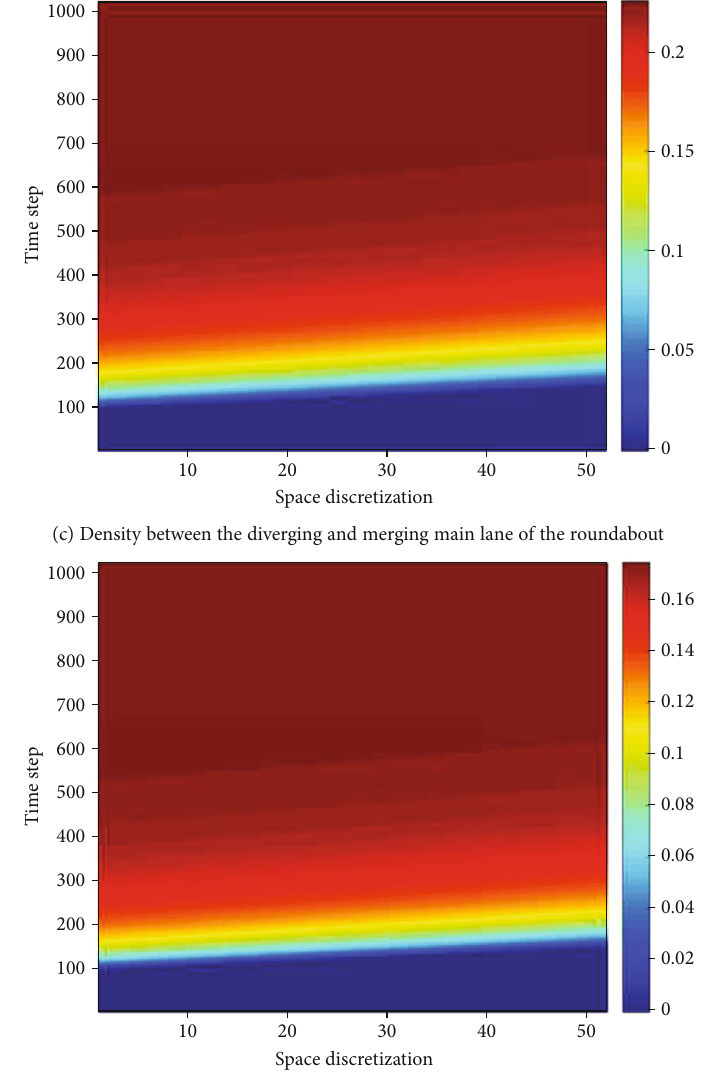
Figure 6: Density and fl ux pro fi les on the entrance and main lane of a roundabout in case 1. In case (a), shock waves are produced on roads I , I , and I , and rarefaction waves are created on roads S 2 3